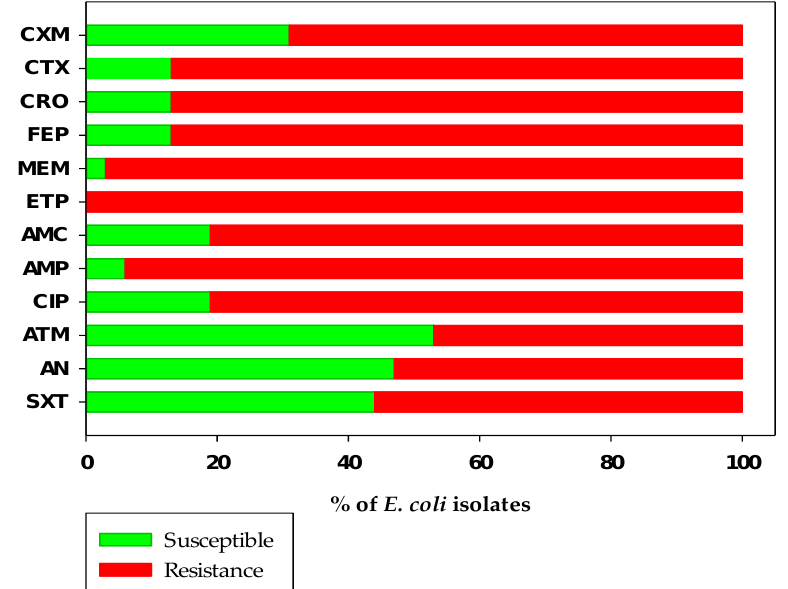
Figure 1. Susceptibility and resistance profile of E. coli strains isolated from the farm and packing facilities from Honeydew melon in Hermosillo, Sonora. Cefuroxime (CXM), cefotaxime (CTX), cef- triaxone (CRO), cefepime (FEP), meropenem (MEM), ertapenem (ETP), amoxicillin/clavulanic acid (AMC), ampicillin (AMP), ciprofloxacin (CIP), aztreonam (ATM), amikacin (AN), and sulfamethoxa- zole/trimethoprim